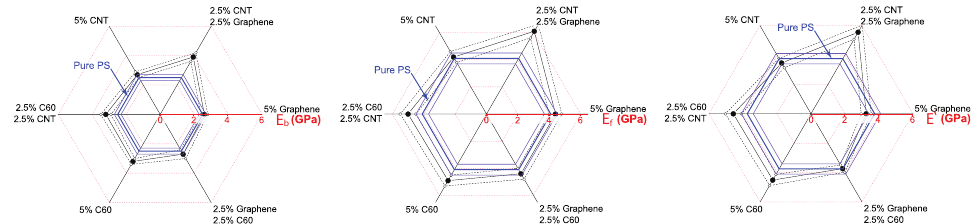
Figure 6. Graphical representation of the data on measured linear elastic moduli (E b , E f , E’) of the pure polystyrene sample (shown in blue) and polystyrene with the addition of single-type inclusions (graphene, C 60 , CNT) and binary mixtures (C 60 + Gr, C 60 + CNT, CNT + Gr) of nanoparticles. Both measured values (filled circles and bold lines) and 68% confidence intervals (dashed lines and empty circles) are indicated.